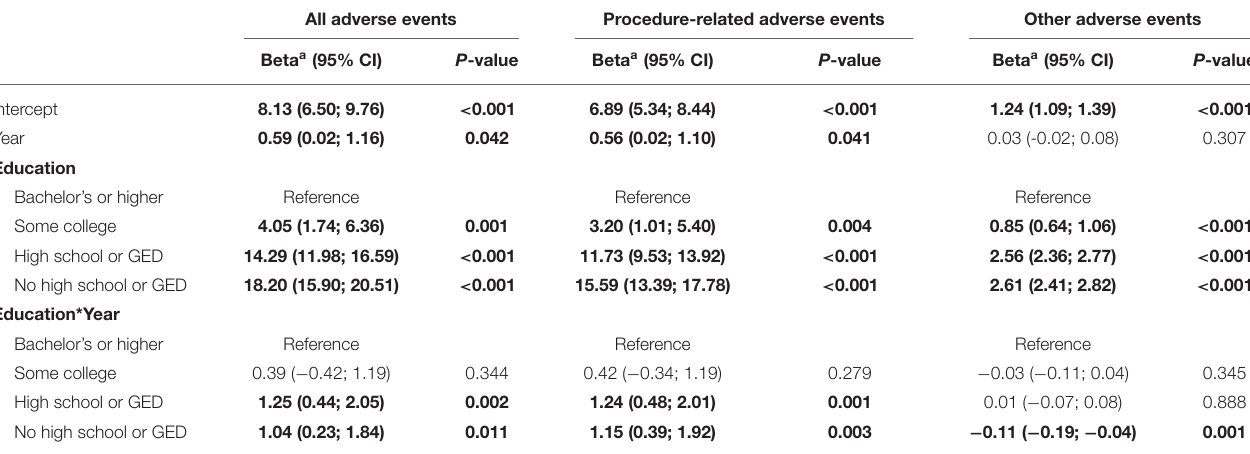
TABLE 3 | Two-level linear mixed models with adverse event AMR (per million per year) as outcome, and education, year and education*year interaction as predictors. All adverse